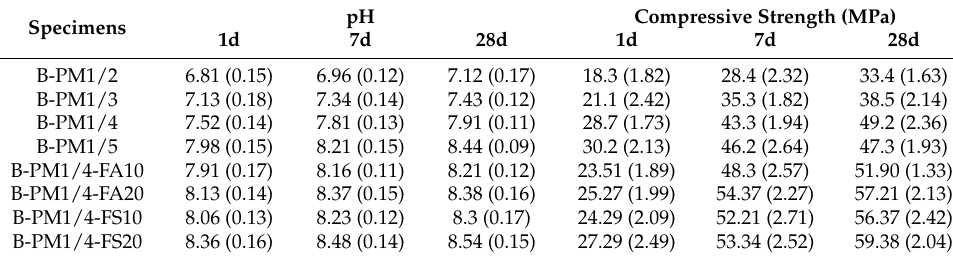
Table 4. pH value and compressive strength of MPC with curing